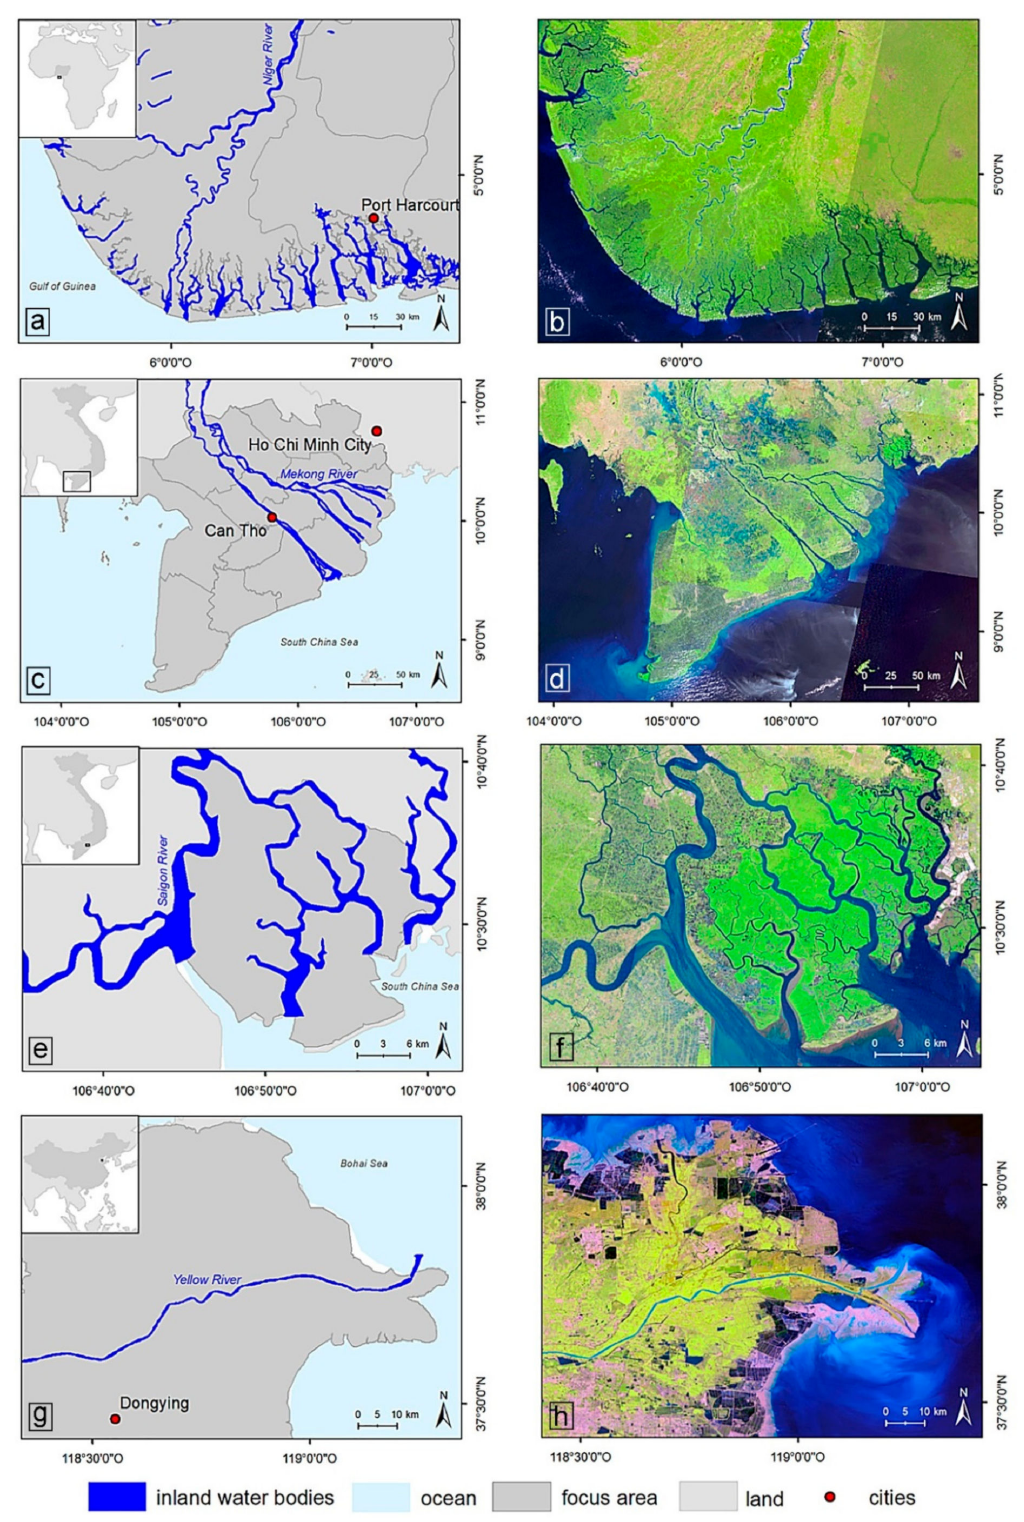
Figure 1. Four selected deltas from top to bottom: Niger Delta, Nigeria ( a , b ); Mekong Delta, Vietnam ( c , d ); Can Gio estuary complex, Vietnam ( e , f ); and Yellow River Delta, China ( g , h ). Left column: Location of each delta. Right column: True color Landsat ( b , d , f ) and Seninel-2 ( h ) images of the same